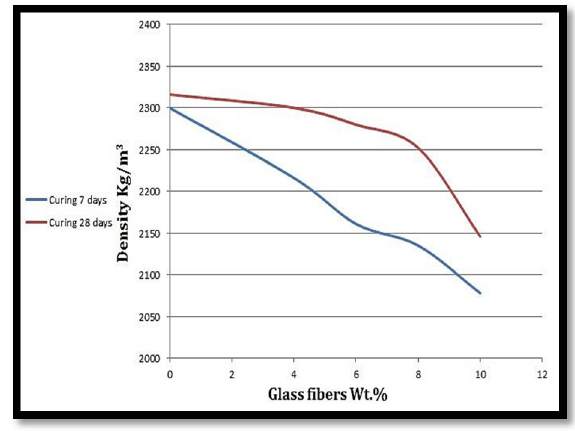
Fig. 4. Effect of random glass fibers addition with SBR after curing for 7 and 28 days.